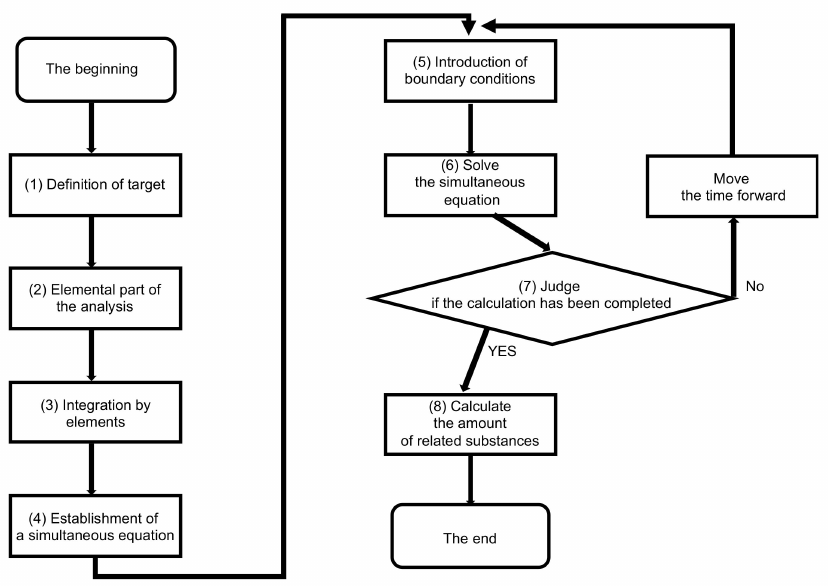
Figure 3. Flowchart of three-dimensional linear elasticity analysis using MIDAS GTS